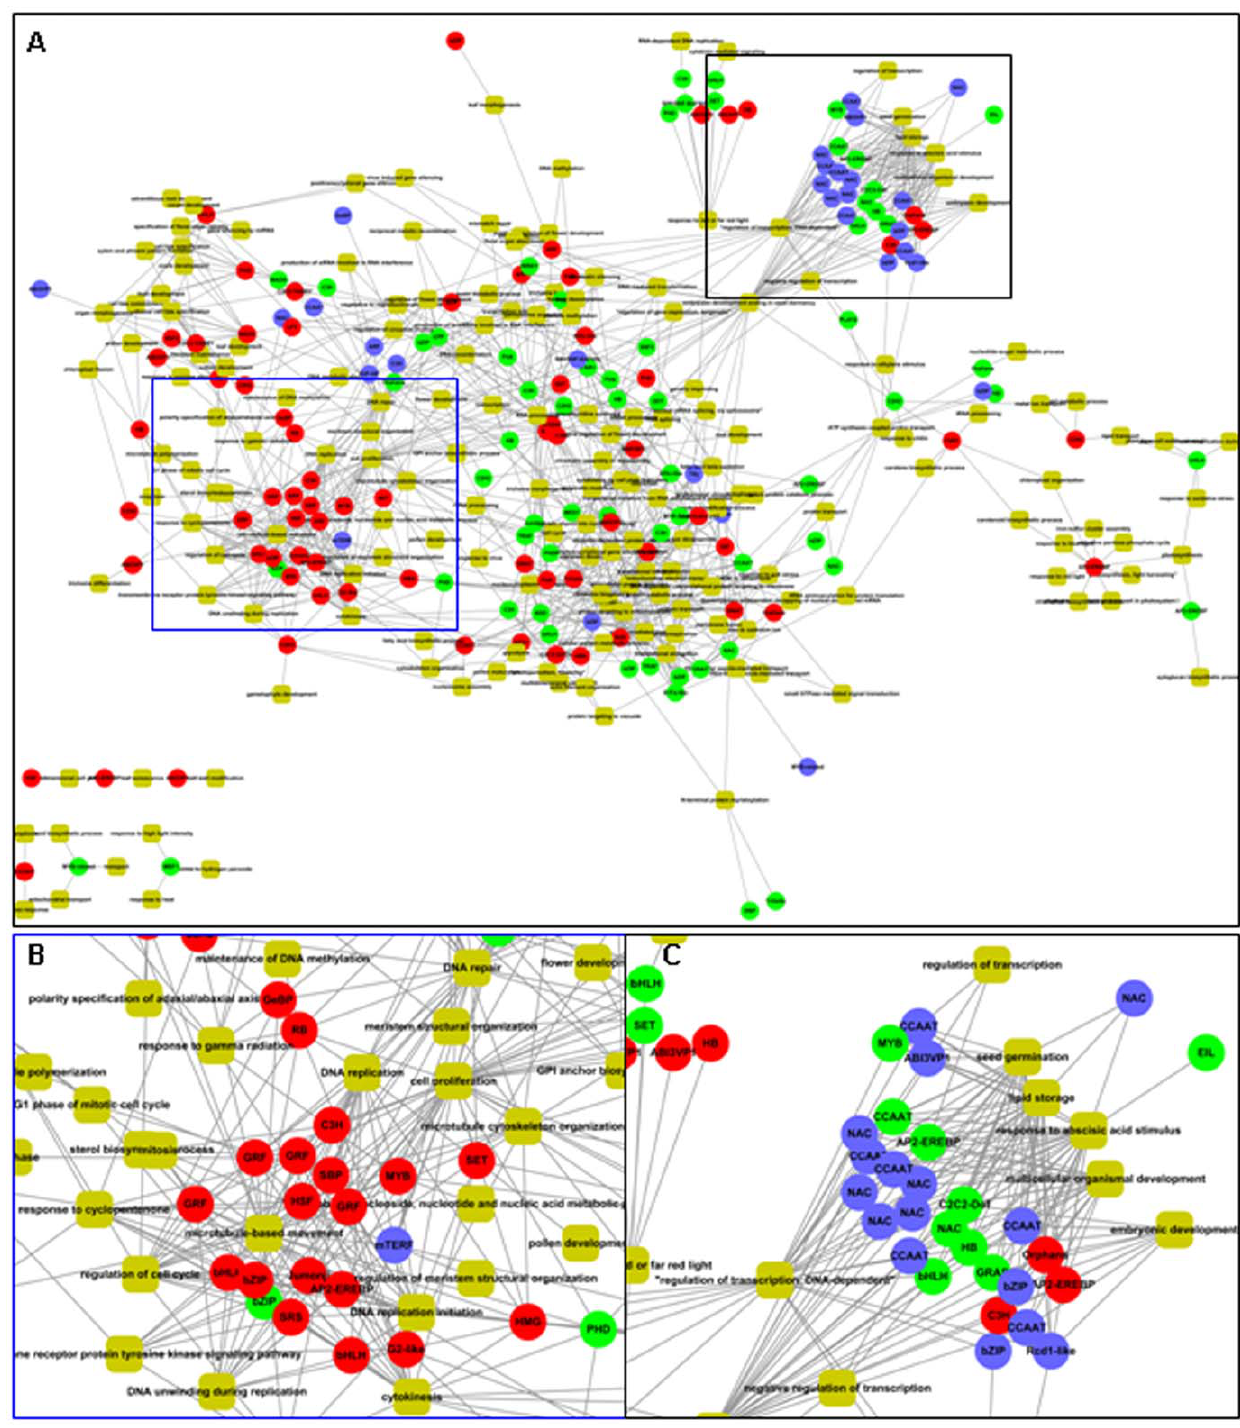
Figure 7. Transcriptional co-expression network involved in seed development. The relationship of transcription factors (circle) and the associated functions (yellow round rectangle) were shown as overview (A) and two modules predominantly expressed in embryo (B) and endosperm (C) respectively, were shown in detail. The circles with red, green and blue colors represent the transcription factors expressed in embryo, endosperm, or both embryo and endosperm.